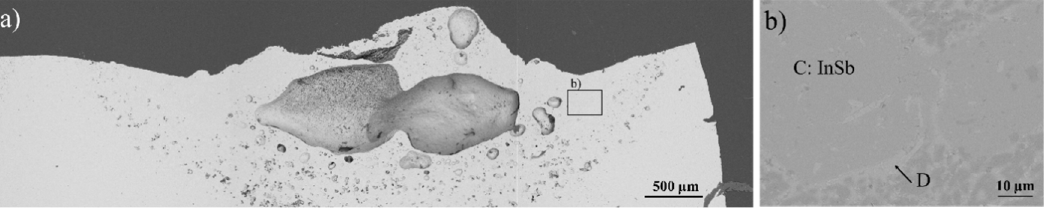
Figure 5. ( a ) SEM-EDS micrograph (BSE) of the cross-section of Fe50_SPS after interaction with AgCuIn. ( b ) SEM-EDS (BSE) magnification of a selected area indicated by rectangle in ( a ) Table 2. EDS chemical analysis (at. %) of di ff erent regions identified in the wetting samples tested with AgCuIn and indicated in Figure 4 (regions A and B) and Figure 5 (regions C and D); at least five spots were analyzed for each